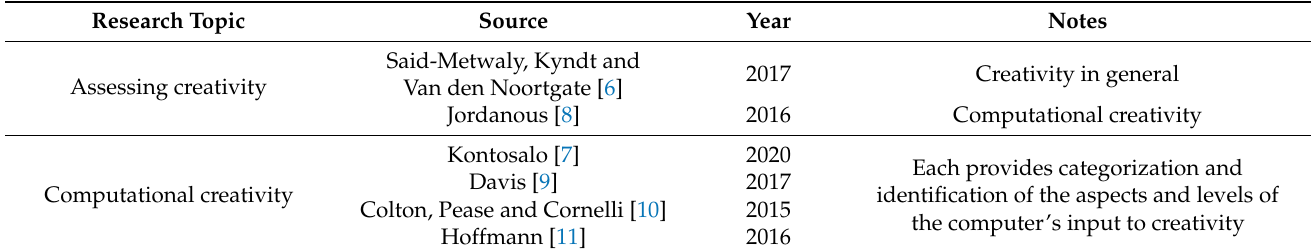
Table 1. Main sources used in the first part of the review (Section